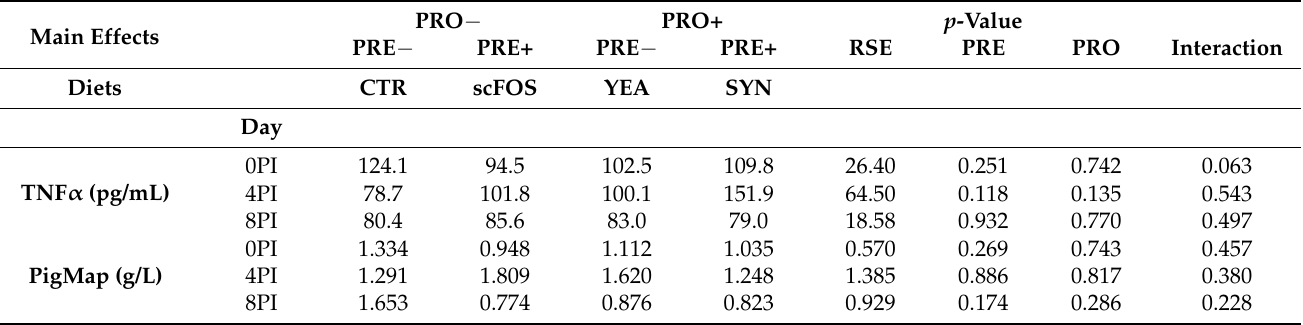
Table 7. Serological levels of TNF- α and Pig-MAP for different experimental treatments expressed as concentrations (pg/mL and g/L, respectively). Values are given for day 0, 4, and 8 post